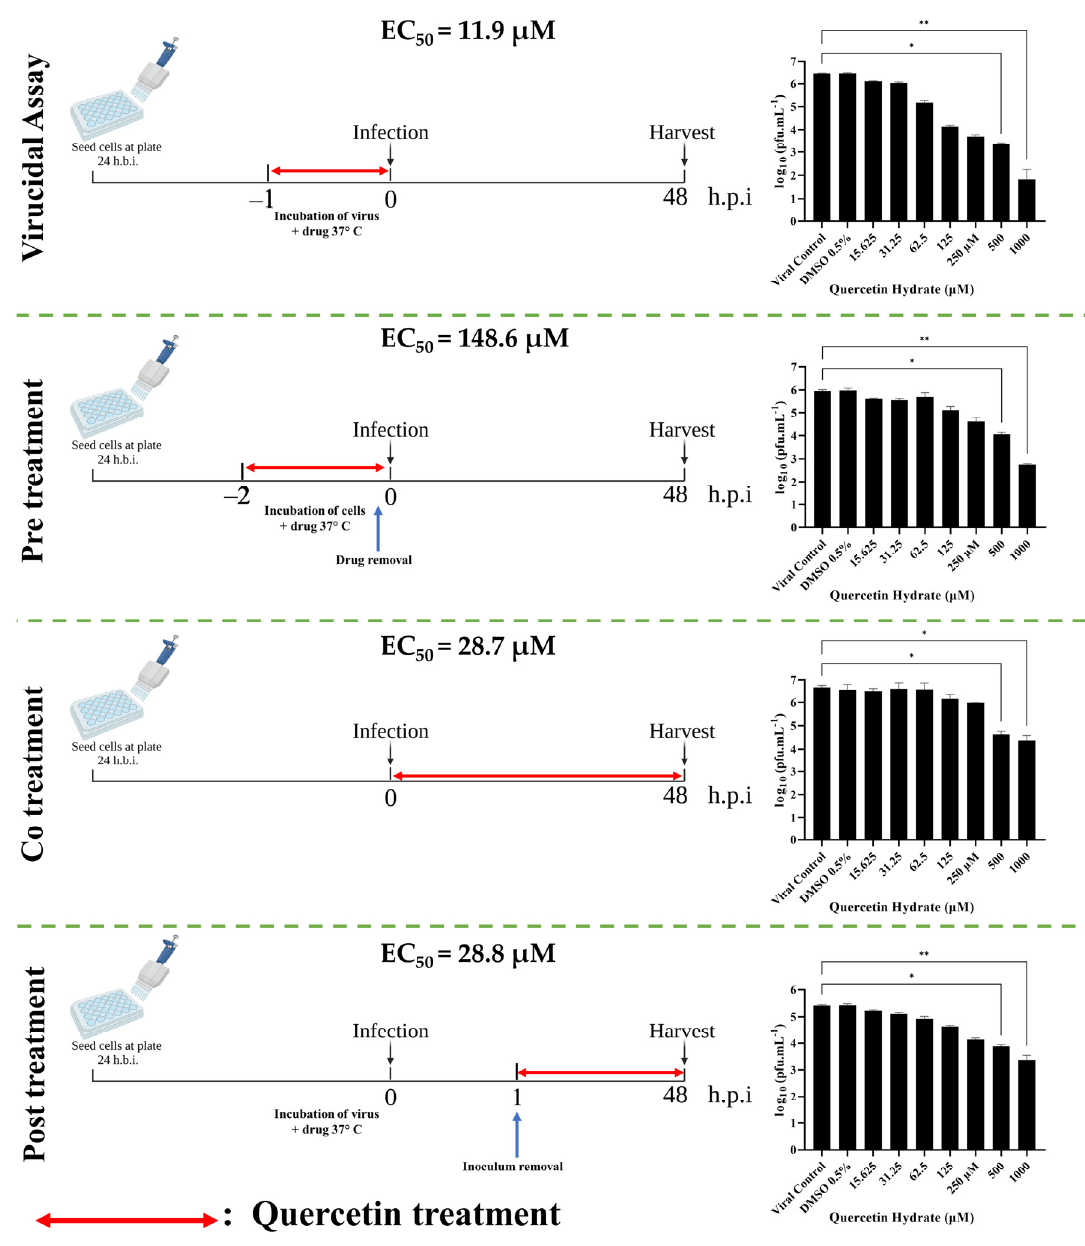
Figure 1. Quercetin hydrate causes dose-dependent inhibition of ZIKV yields. Vero cells were treated with DMSO solvent control or 1000–15.625 µM of quercetin hydrate in indicated conditions prior to infection with ZIKV at MOI = 0.1. The supernatant was titrated at 48 h post-infection. Mean values with standard deviation from three independent experiments, measured in triplicate, are shown. (*, p < 0.05/**, p < 0.01).